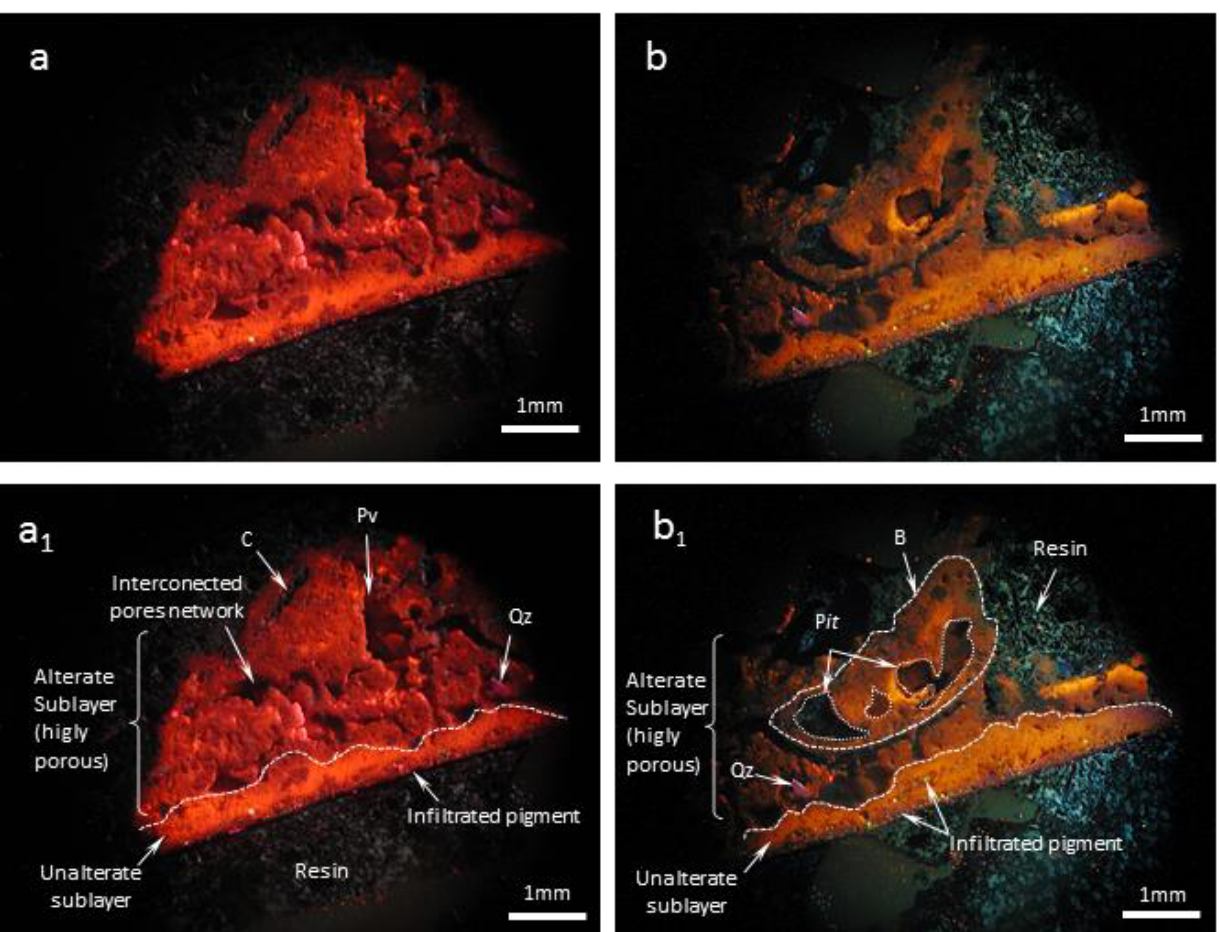
Figure 4. Cathodoluminescence analysis. Fragment of the fresco with two distinct areas: an external unaltered sublayer and an internally altered layer with high porosity. ( a1 ) interpreted image of image ( a , b1 ) interpreted image of image ( b ): Qz-quartz; C-fragment of carbonized plant (straw); PV-vacuolar porosity; B-bioclast; Pit-intraparticle porosity.